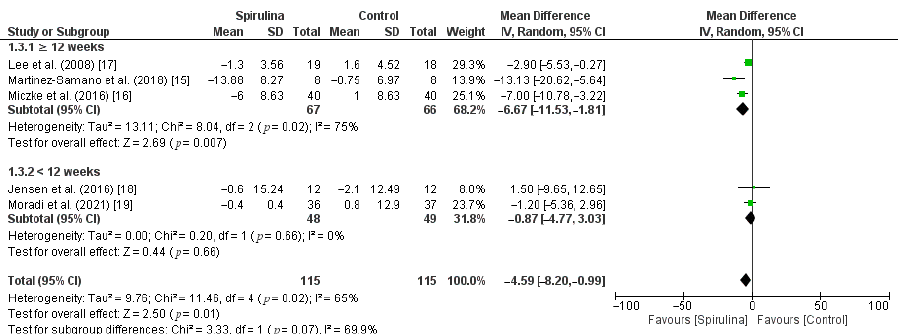
Figure 5. Effect of Spirulina supplementation on systolic blood pressure (SBP) compared with the control group stratified by duration of Spirulina intake [15–19].